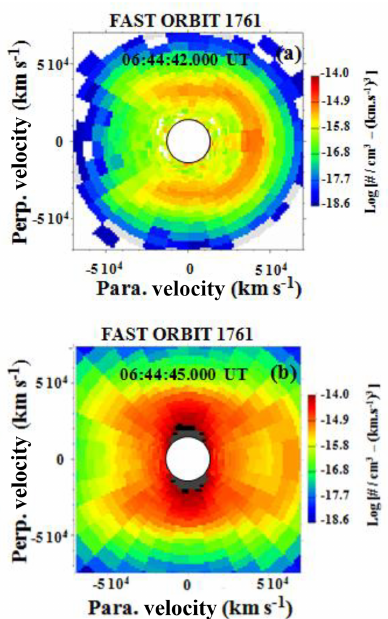
Figure 3. Panel (a) plots the full-ring horseshoe electron distribu- tion recorded inside the density cavity at ∼ 06:44:42UT before the DL crossing. Panel (b) displays the electron distribution measured at 06:44:45UT in the regions of enhanced density located on the high-potential side of the recorded DL; it exhibits a pronounced beam-like character. The distributions are plotted in perpendicular, parallel velocity space. Positive values of the parallel velocities cor- respond to earthward propagation. Both distributions are averaged over ∼ 0.8s. The background electron fluxes with energy less than ∼ 1keV have been